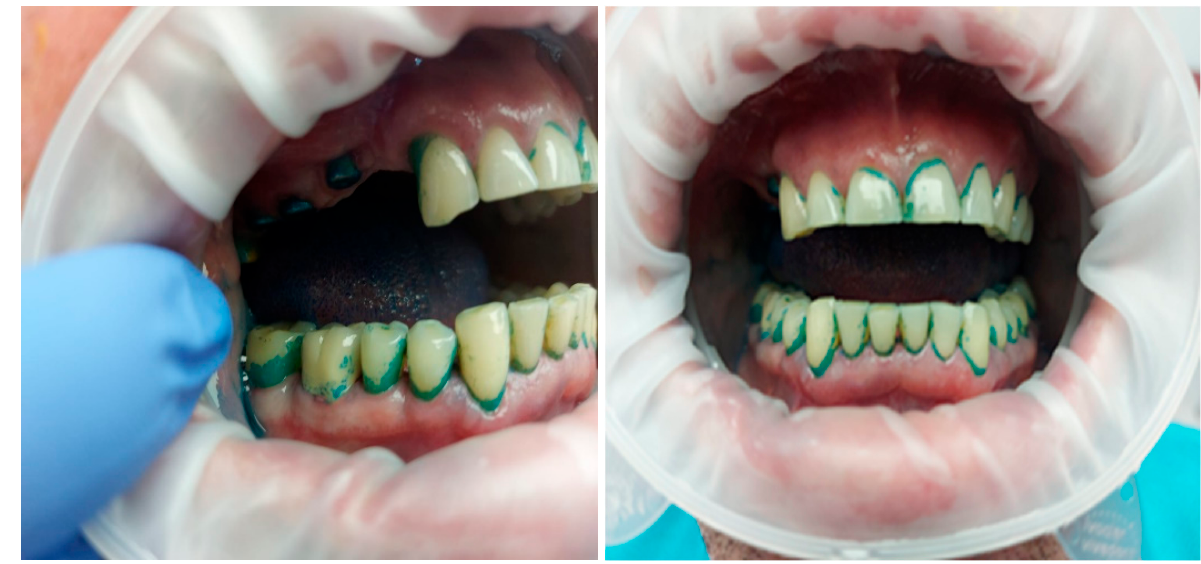
Figure 2. Patient D.B-methyl blue solution.